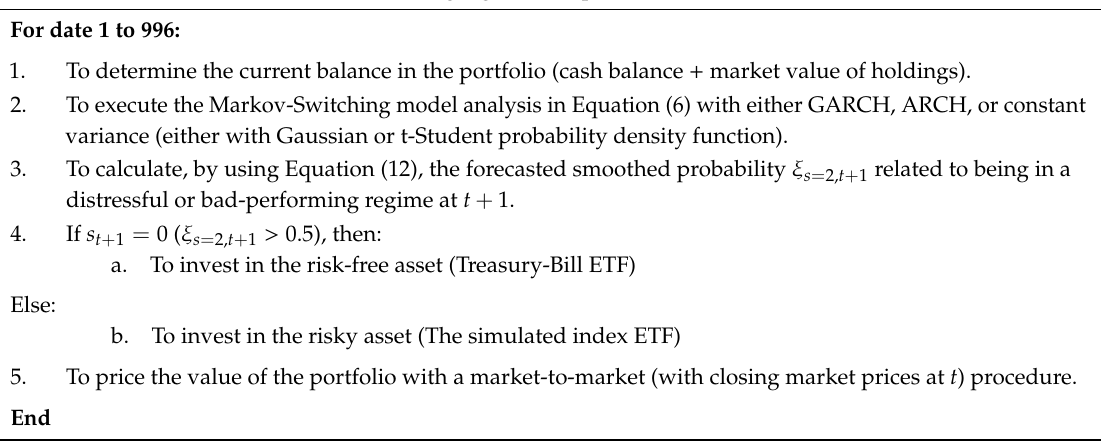
Algorithm 1. The MS-GARCH based trading algorithm’s